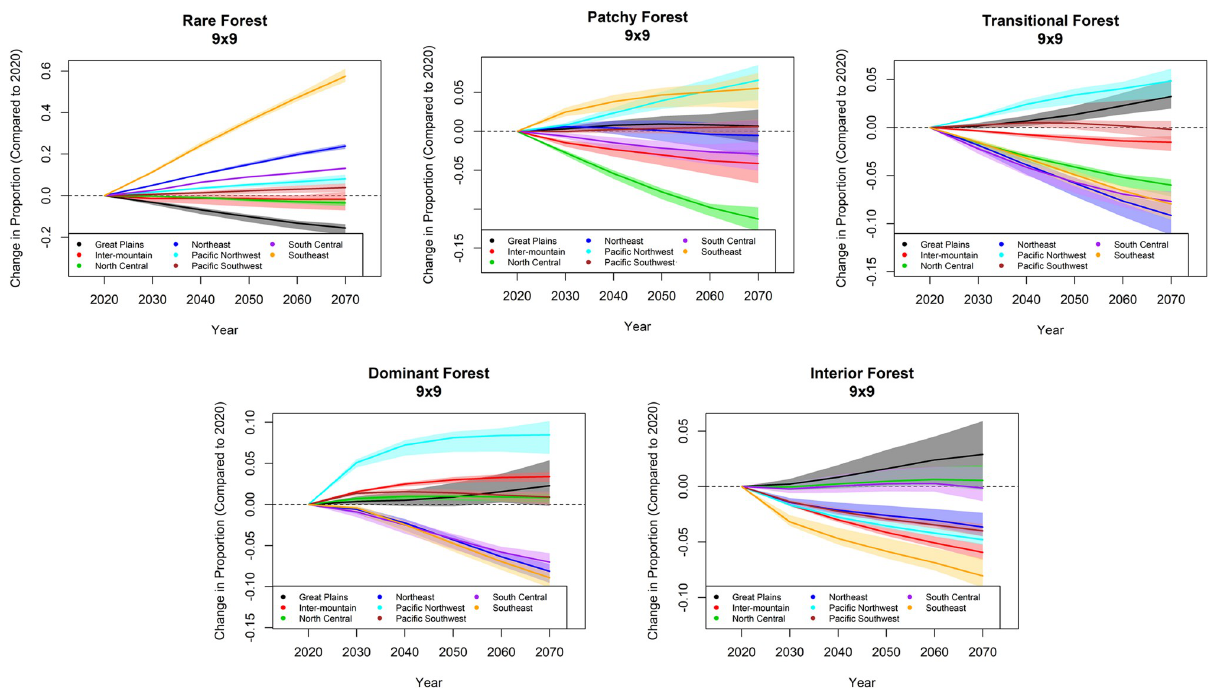
Fig 9. Forest pattern trajectories. Projected change in forested area from 2020–2070, by forest fragmentation class (Table 3; Fig 5) and RPA subregion (Fig 2). Change is given as a percentage of the 2020 area. The lines represent the median value across 20 realizations; the polygons represent the corresponding inter-quartile